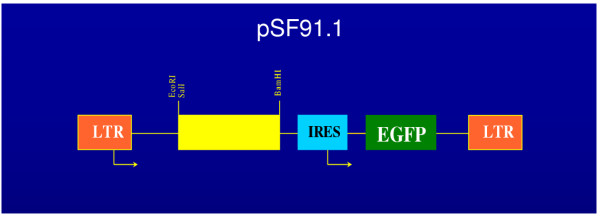
Retroviral vector pSF91.1. Depiction of the retroviral vector utilized in these experiments demonstrating restriction sites and location of entry of the gene of interest between the LTR and the IRES.